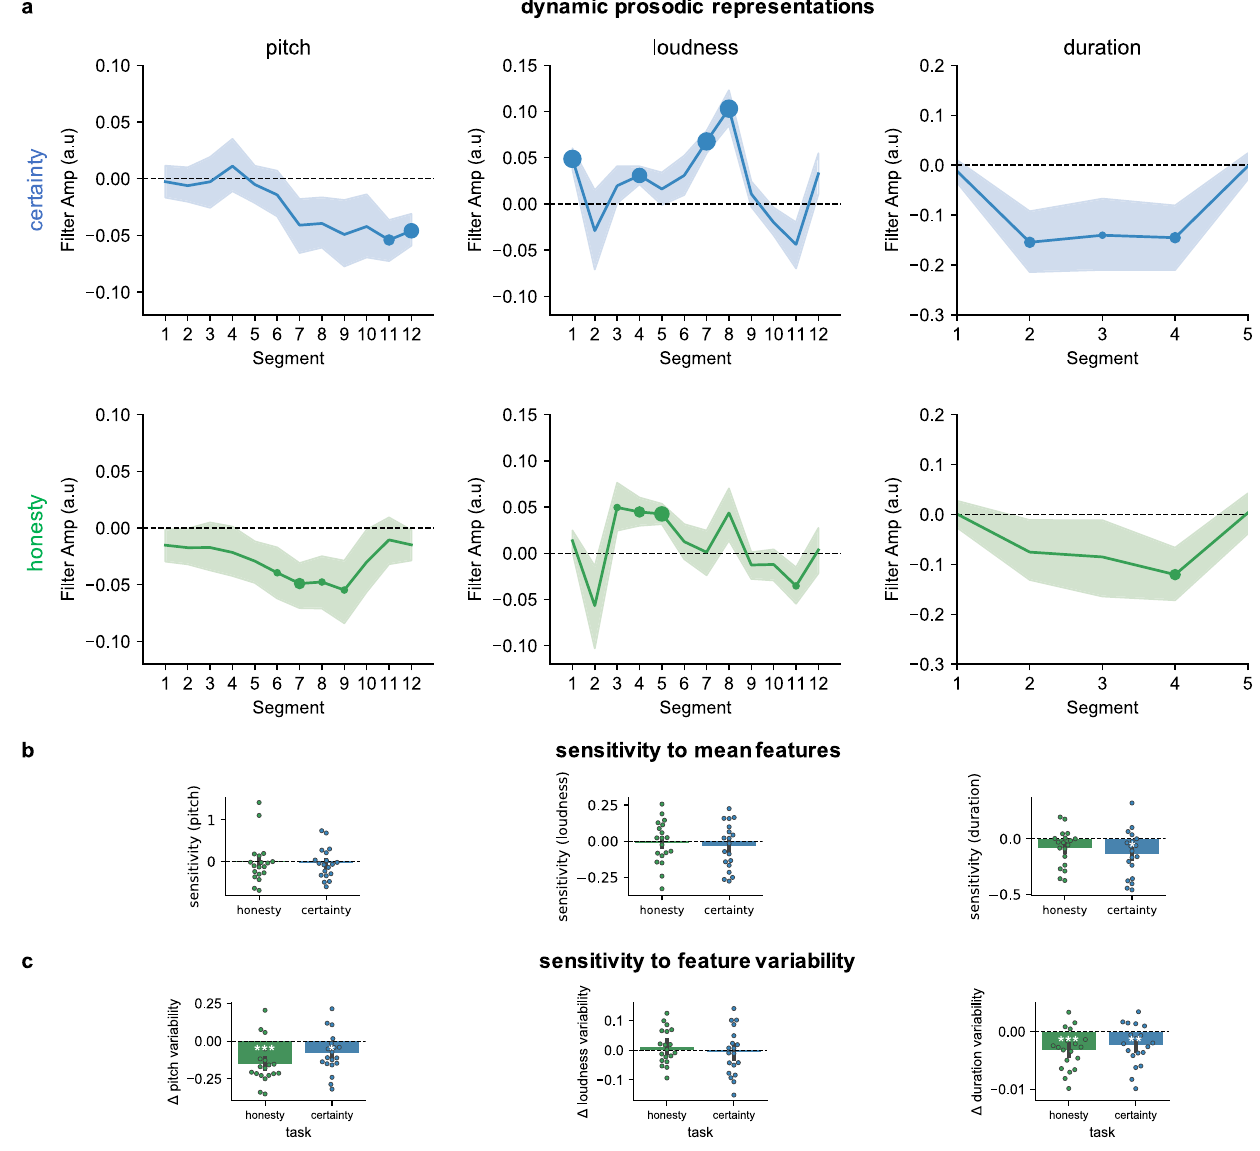
Fig. 1 Reverse correlation results (study 1). a Dynamic prosodic representations. Normalized kernels derived from the reverse correlation analyses in both tasks (top: certainty, blue; bottom: honesty, green) across the three acoustical dimensions (pitch, loudness, and duration). Filter amplitudes (a.u., arbitrary units) correspond to the values obtained for each participant, task, acoustic dimension, and segment by subtracting the average (pitch, loudness, and duration) values obtained for stimuli judged as certain/honest from the values averaged for the unchosen stimuli and normalizing these values for each participant by dividing them by the sum of their absolute values. Data show group averages, with shaded areas showing the SEMs. Signi fi cant deviations from zero (one-sample two-sided t tests) are indicated at the corresponding segment positions by circles, with increasing sizes corresponding to p < 0.1; p < 0.05; p < 0.01, and p < 0.001; certainty task ( p values per segment for pitch: 0.86, 0.69, 0.91, 0.64, 0.77, 0.49, 0.11, 0.11, 0.13, 0.14, 0.01, 0.004; loudness: 0.0005, 0.51, 0.37, 0.007, 0.38, 0.18, 0.0001, 0.0001, 0.44, 0.22, 0.12, 0.16; duration: 0.6, 0.03, 0.07, 0.04, 0.94); honesty task (pitch: 0.33, 0.29, 0.44, 0.34, 0.14, 0.09, 0.03, 0.06, 0.08, 0.30, 0.62, 0.30; loudness: 0.29, 0.24, 0.07, 0.01, 0.002, 0.53, 0.96, 0.17, 0.42, 0.5, 0.098, 0.88; duration: 0.98, 0.24, 0.30, 0.048, 0.94). Kernels were computed for 5 time points for duration (corresponding to the initial values of the audio transformations) and in 12 time points for pitch and duration (corresponding to post-transformation acoustic analysis of the stimuli, see “ Methods ” ). Individual raw (i.e., non- normalized) kernels are shown in Fig. SII.a. b Sensitivity to mean features. To assess the extent to which mean pitch, loudness, and duration affected participants ’ judgments at a static level, we constructed for each participant and task psychometric functions relating sensory evidence (computed for each trial as the area under the curve corresponding to the difference between the dynamic pro fi les of the fi rst minus second stimuli) to participant ’ s choices (i.e., the probability to choose the fi rst stimulus). Bar plots show the slopes averaged over the group separately in each task, with error bars showing the SEM. Dots show individual data. The white asterisk shows the result of one-sample Wilcoxon signed-rank test with p < 0.05; pitch (0.33/0.19), loudness (0.4/0.84), duration (0.012/0.053). c Sensitivity to feature variability. For each trial, the standard deviation of the pitch, loudness, and duration for the stimuli judged as more reliable (honest, certain) were subtracted from the stimuli judged as less reliable (lying, doubtful; Δ : difference). Bar plots show the slopes averaged over the group separately in each task, with error bars showing the SEM. Dots show individual data. White asterisks show the result of one-sample t test against chance with p < 0.05; ** p < 0.01; *** p < 0.001; pitch (certainty p = 0.017/honesty p = 0.0002); loudness variability (0.7/0.4); duration variability (0.009/0.0007). Source data are provided as a Source data fi le.